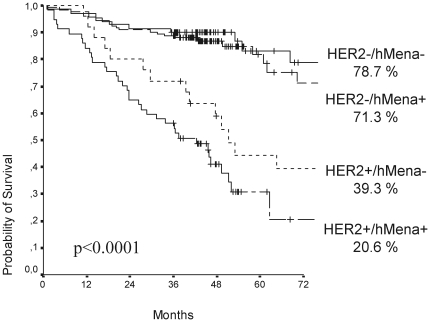
hMena overexpression adds prognostic information in HER2 overexpressing tumors.Kaplan-Meier estimates of disease-free survival (DFS) for hMena and HER2 status show that hMena/HER2 covariates have a different effect on DFS in relationship to the different phenotype combinations. In particular, the lower percentage of disease free patients at 6 year follow up was found in the group of HER2+/hMena+ tumors (p<0.0001).